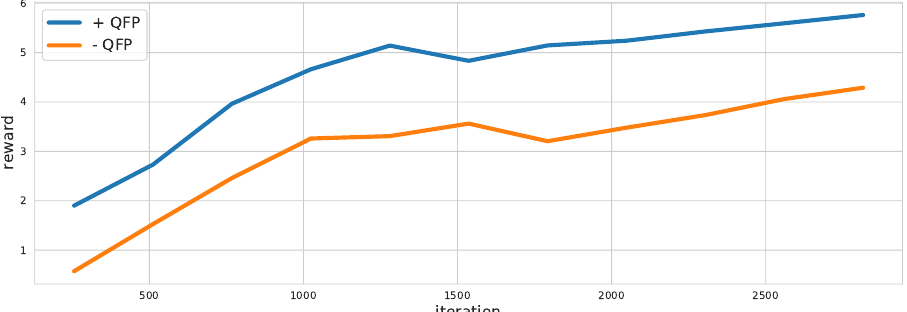
Figure 11. The reward graph of the CFA+QFP and CFA-QFP models. The reward graph shows that the disturbance information predicted from the QFA is useful to the CFA